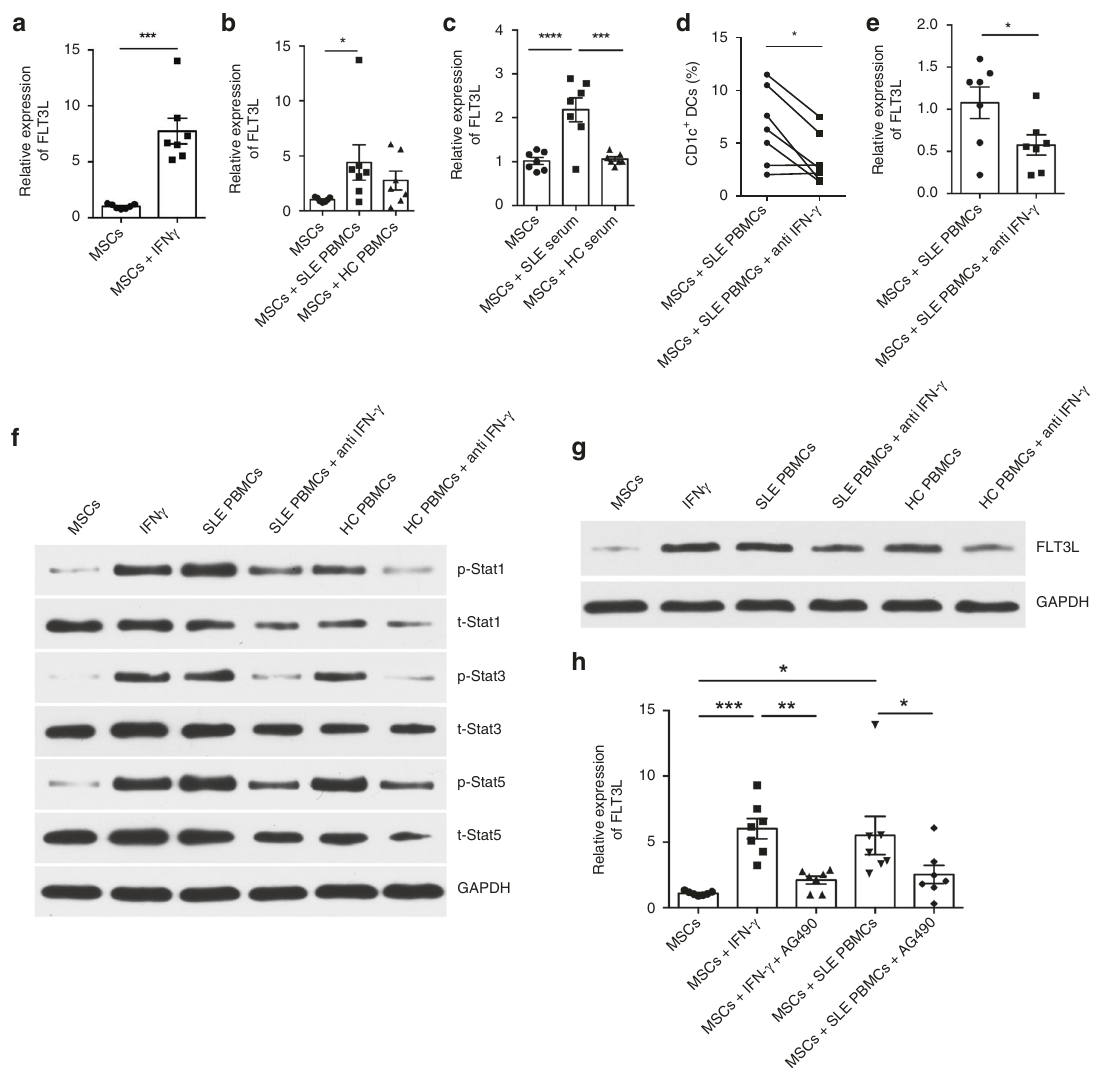
Fig. 5 IFN- γ promotes FLT3L in UC-MSCs via JAK/STAT pathway. a , b , c The expression of FLT3L in UC-MSCs was analyzed by real-time PCR after stimulated by IFN- γ (20 ng/ml) ( a ), SLE/HC PBMCs ( b ) and SLE/HC serum ( c ) ( n = 7). d , e SLE PBMCs were co-cultured with UC-MSCs with or without anti-IFN- γ monoclonal antibody for 72 h. The percentage of CD1c + DCs in PBMCs was analyzed by fl ow cytometry ( n = 7) ( d ), and the expression of FLT3L in UC-MSCs was assessed by real-time PCR ( n = 7) ( e ). f Stat1, Stat3, Stat5 and their phosphorylated forms were assessed by western blot analysis after treatment with UC-MSCs alone, UC-MSCs with PBMCs from SLE patients or HC, and UC-MSCs with PBMCs and anti-IFN- γ monoclonal antibody, or recombinant human IFN- γ . g FLT3L protein level produced by UC-MSCs was assessed by western blot analysis after treatment with UC-MSCs alone, UC- MSCs with PBMCs from SLE patients or HC, and UC-MSCs with PBMCs and anti-IFN- γ monoclonal antibody, or recombinant human IFN- γ . h UC-MSCs were cultured alone, or co-cultured with SLE PBMCs with or without AG490 (20 nM), or treated with IFN- γ with or without AG490. The expression of FLT3L in UC-MSCs was assessed by real-time PCR ( n = 7). The experiments were repeated ≥ 3 times (* p < 0.05, ** p < 0.01, *** p < 0.001, **** p <